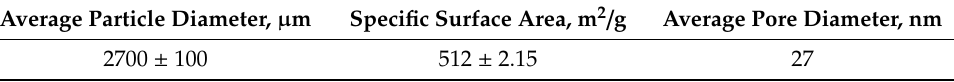
Table 2. Characteristics of the obtained alginate-based aerogel particles.